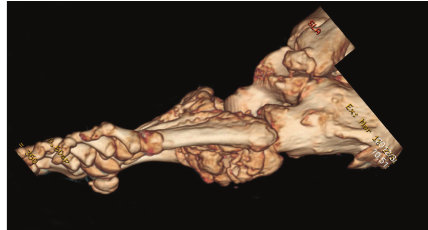
Figure 4: 3D CT of the left foot: plantar prominence of tarsal bones and in this case plantar prominence of cuboid